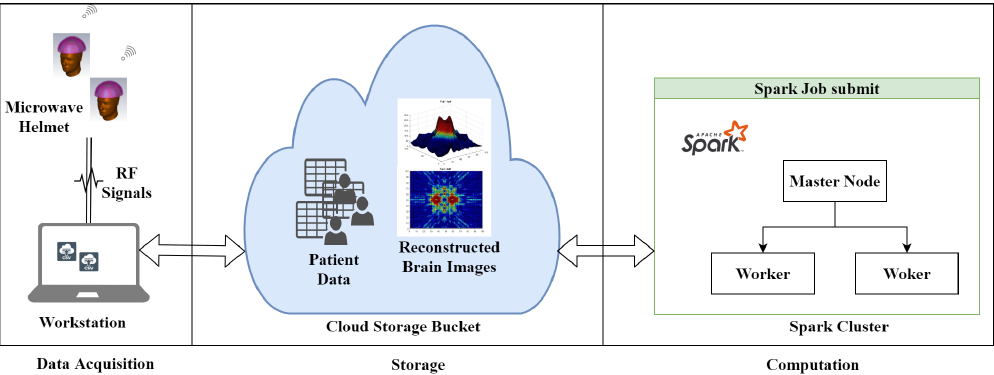
Figure 9. PMIR on Google Cloud Platform (GCP). The data is first send to cloud storage bucket. The master node reads the data, distributes to worker nodes for computation, and saves the output image back to storage